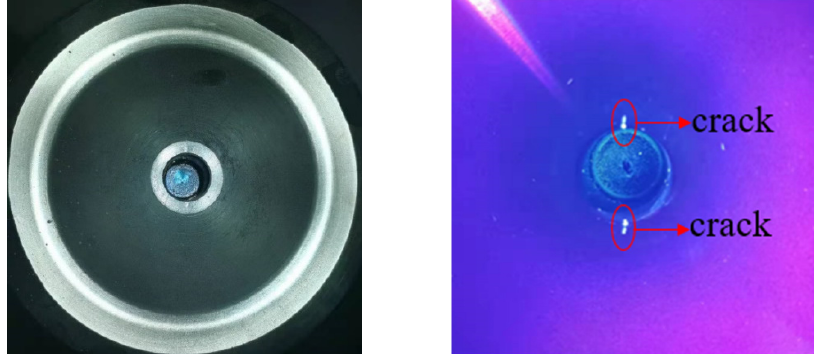
Figure 14. Crack length from fluorescence detection.